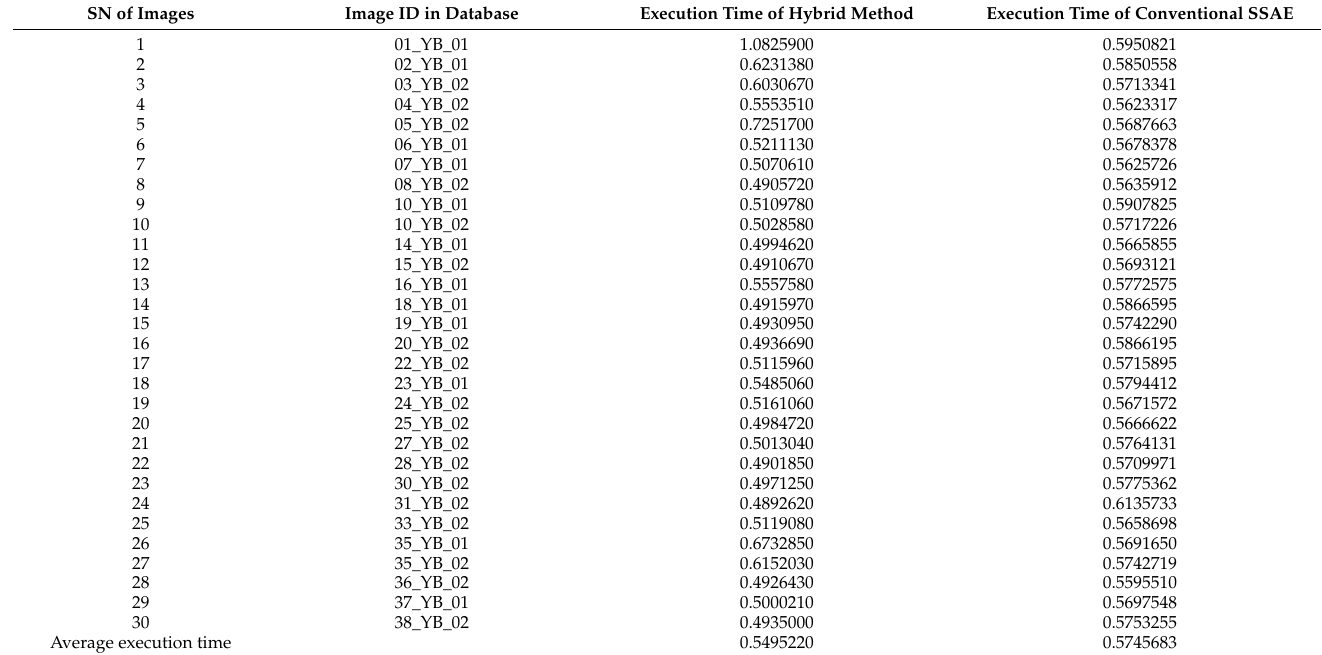
Table 4. Execution time computed for the Extended Yale-B database.